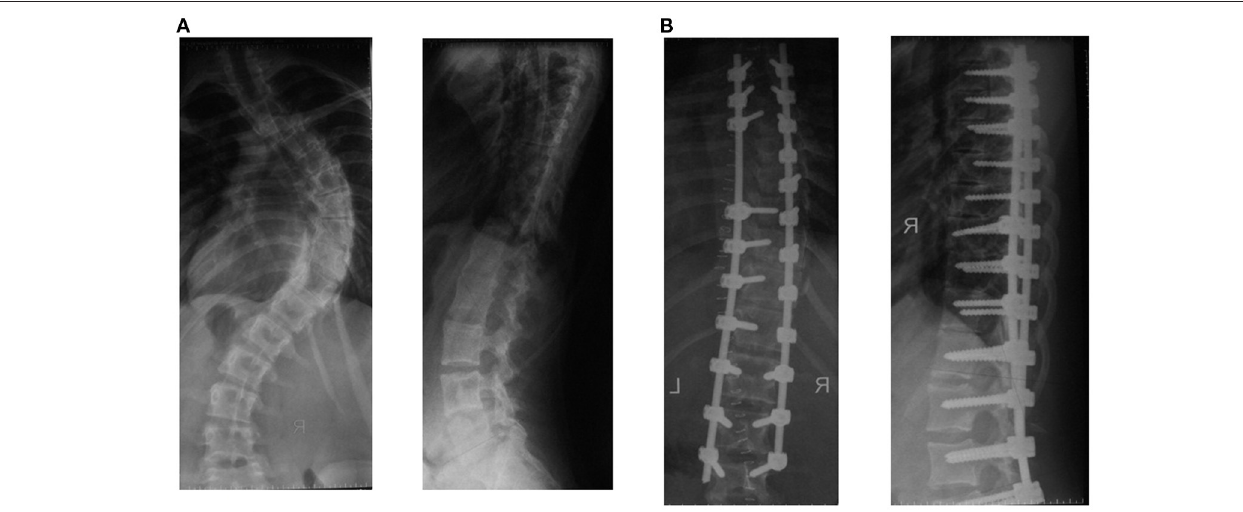
FIGURE 6 | Spinal radiographs of patient B (16 years old). Idiopathic right thoracic scoliosis. (A) Preoperatively, the angle of deformity was 78 ◦ according to Cobb, the angle of kyphosis was 7 ◦ , and the angle of lordosis was 38 ◦ . (B) Postoperatively, the angle of scoliosis was 16 ◦ according to Cobb, the angle of kyphosis was 12 ◦ , and the angle of lordosis was 25 ◦